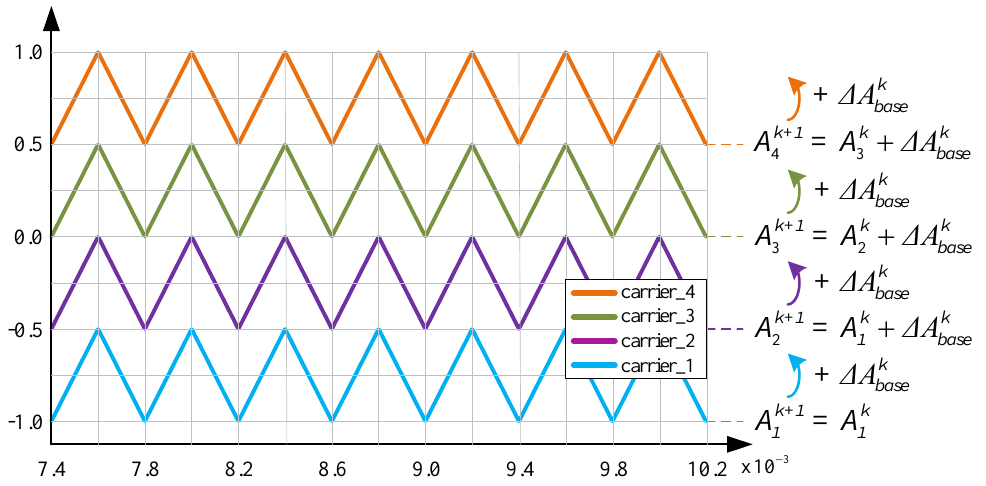
Figure 9. Proposed rule for the carrier level update with DSA-LSC method.